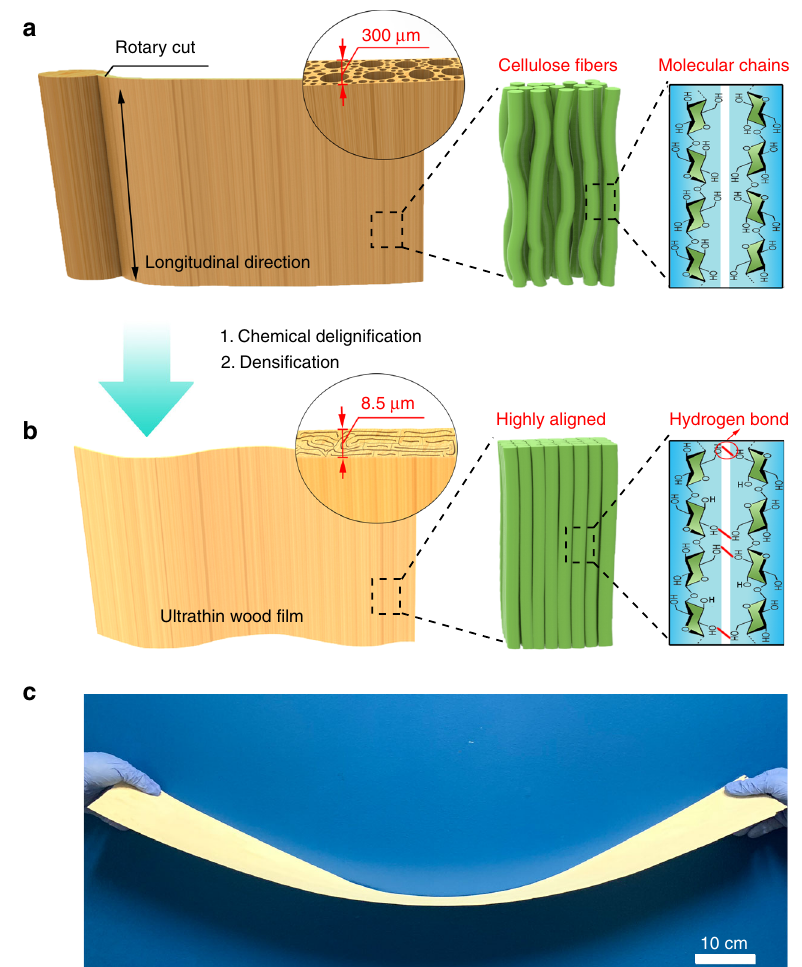
Fig. 1 Schematic of the top-down approach to directly transform natural balsa into ultrathin wood fi lms. a Left: schematic of the natural wood with its porous structure. Middle: the microstructure of the cellulose fi bers in the wood cell walls. Right: the molecular chains of the cellulose fi bers. b Left: schematic of the ultrathin wood with intertwined, compressed wood channels. Middle: the microstructure of the highly oriented cellulose fi bers in the ultrathin wood cell walls. Right: hydrogen bond formation between the neighboring cellulose molecular chains. c Meter-long natural balsa wood with a thickness of 300 μ m made in the